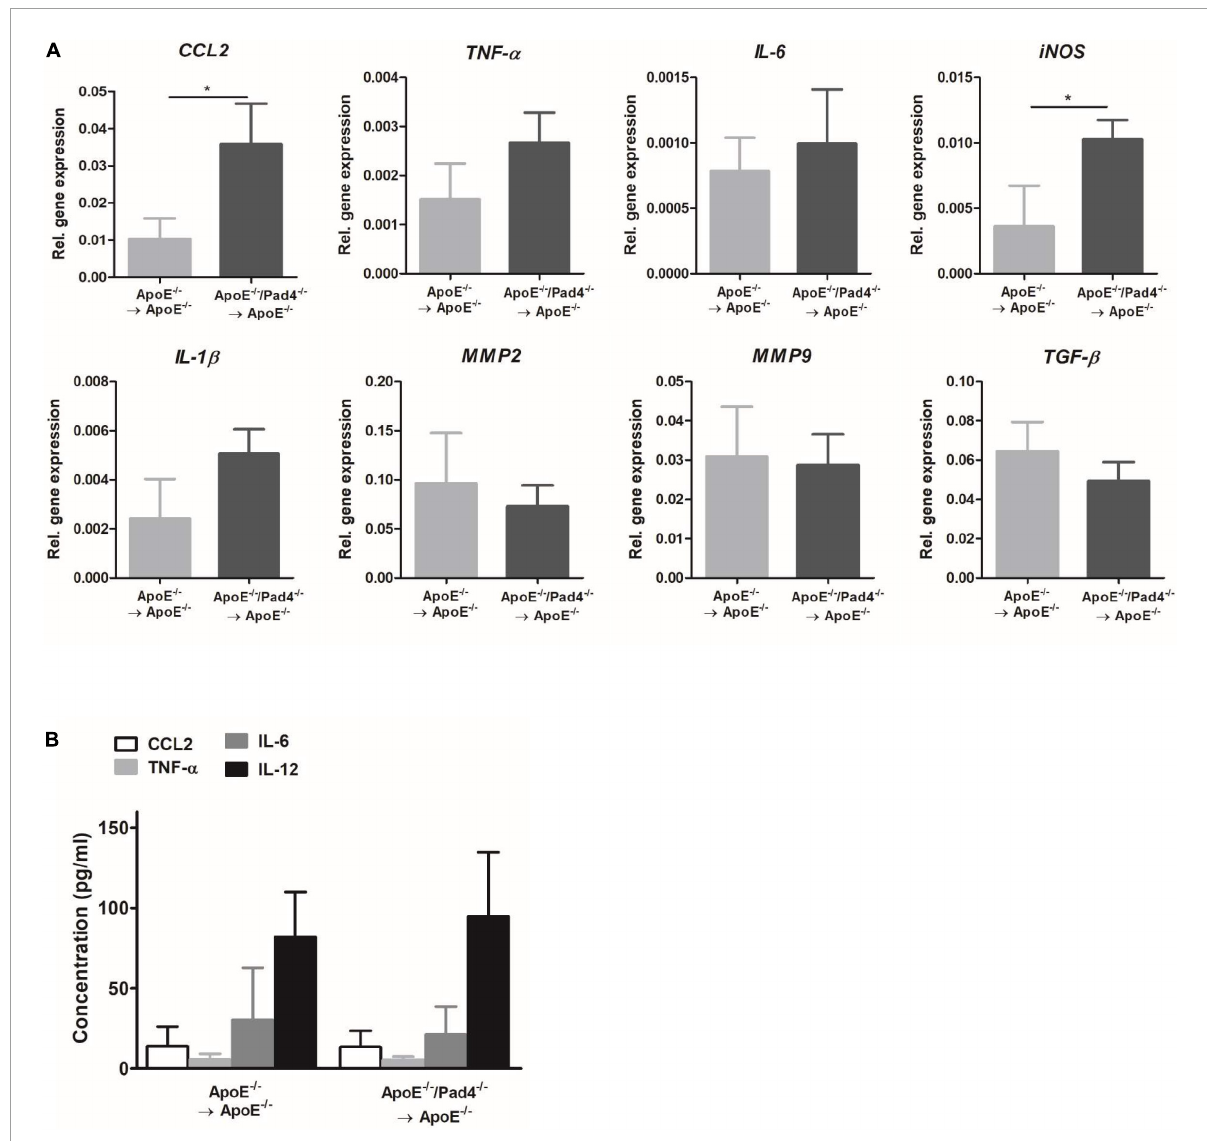
FIGURE6 Impact of bone marrow cells-restricted PAD4 deficiency on vascular and systemic inflammation. (A) Expression of the pro-inflammatory genes CCL2 , TNF- α , IL-6 , iNOS , IL-1 β and the fibrosis-related genes MMP2 , MMP9 and TGF- β in the aortas of mice fed a high-fat diet (HFD) for 10 weeks. n = 4/group. (B) Quantification of CCL2, IL-6, TNF- α and IL-12 in plasma samples after 10 weeks of HFD by Multiplex assay. n = 8/group * p <